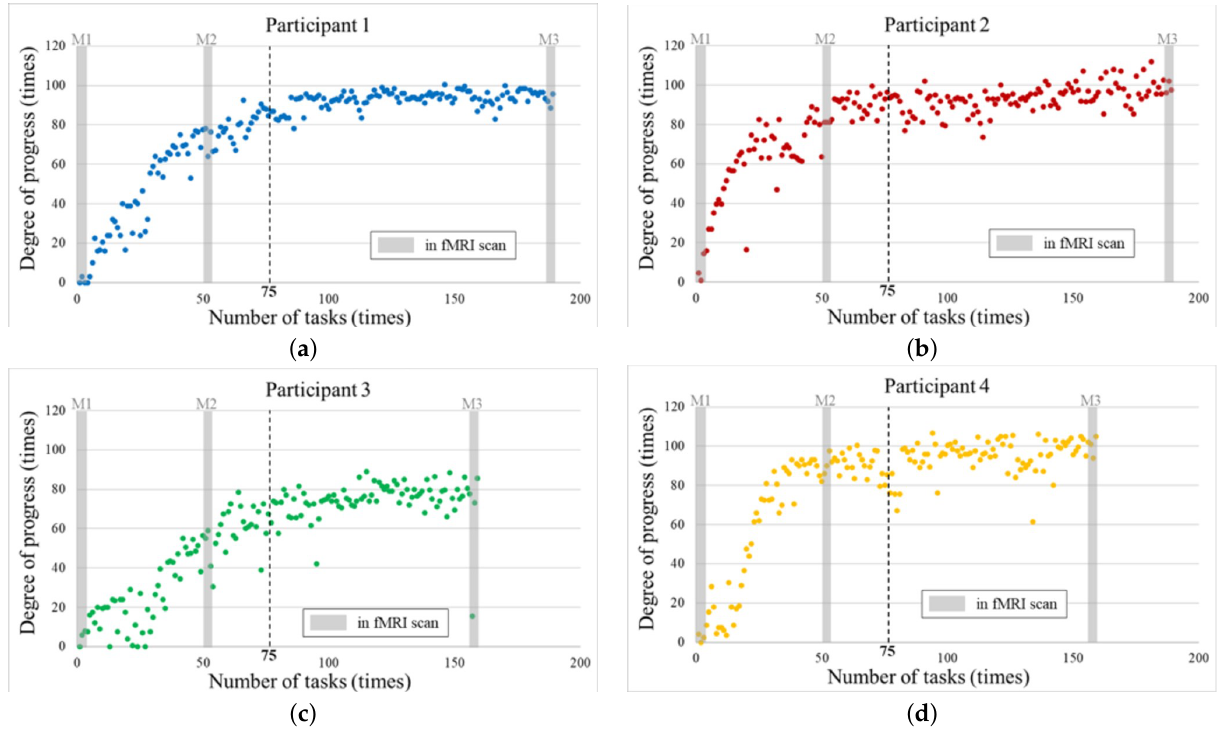
Figure 7. Learning curve for the degree of progress; ( a ) Learning curve for Participant 1; ( b ) Learning curve for Participant 2; ( c ) Learning curve for Participant 3; ( d ) Learning curve for Participant